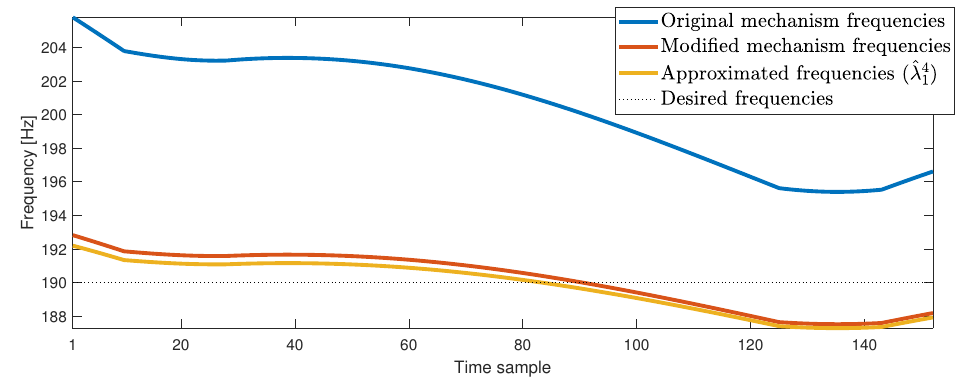
Figure 4. Comparison of original and optimal design.